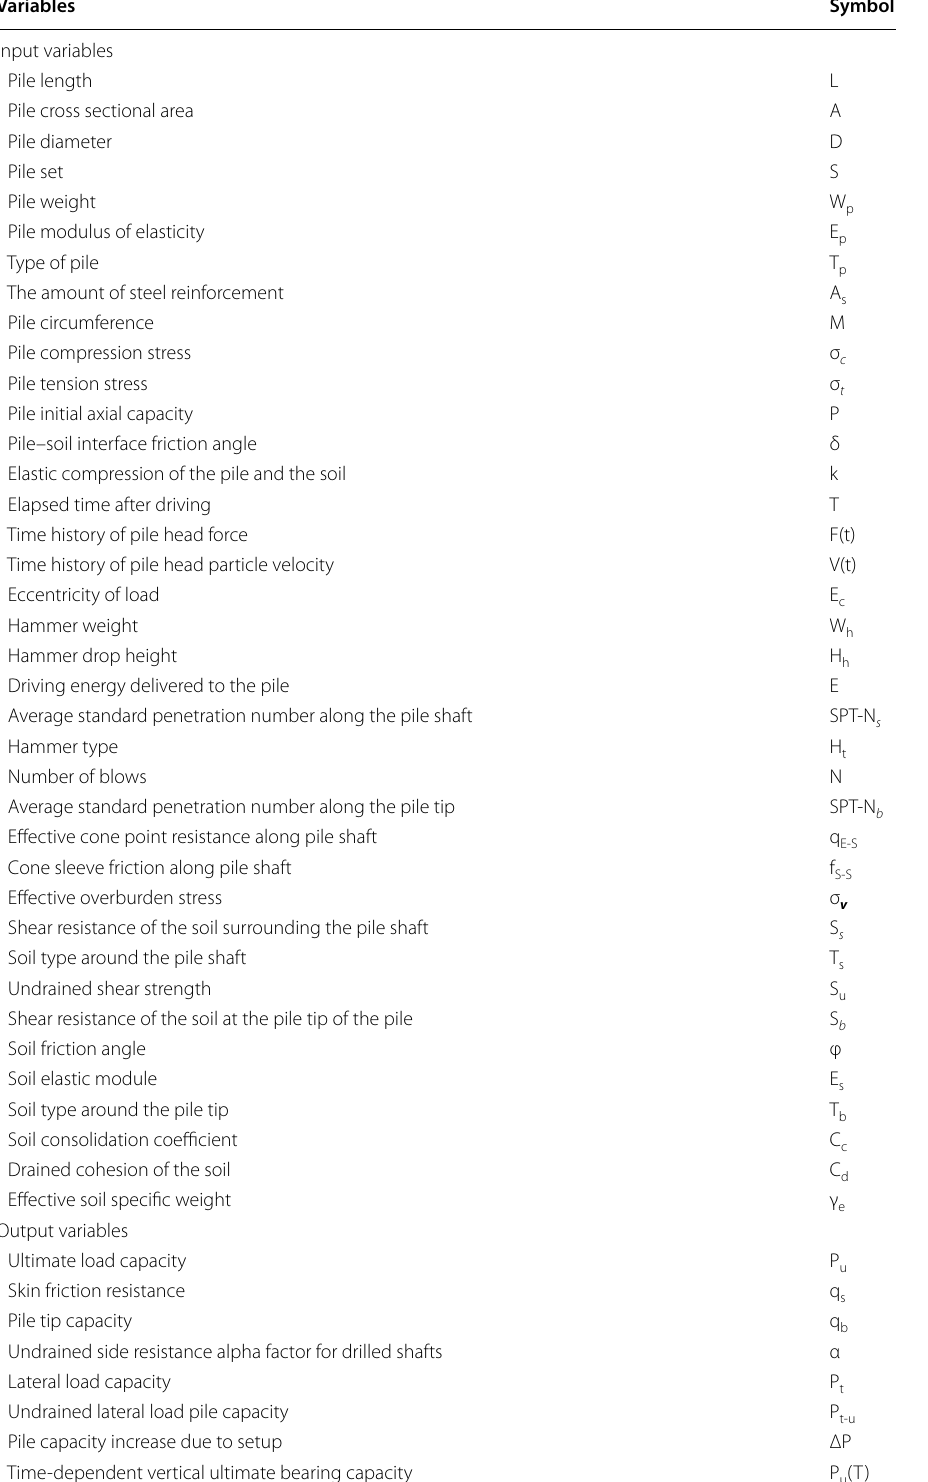
Table 1 ANN input and output